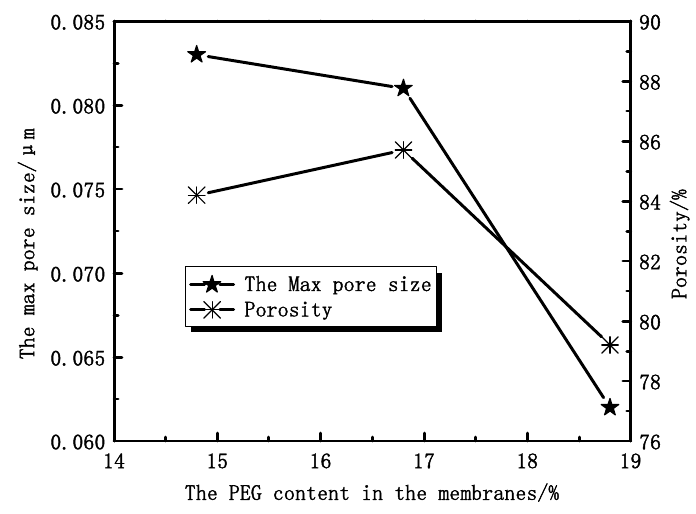
Figure 11. The effect of PEG content on membrane maximum pore size and porosity.